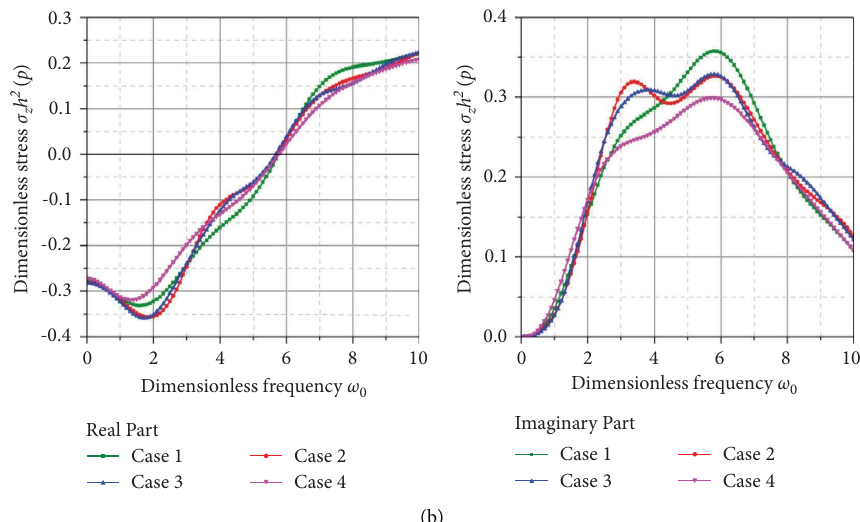
Figure 15: Te real and imaginary parts of (a) the vertical displacement and (b) the vertical stress at a fxed surface point ( r , θ , z ) � (0.5 h , 0, 0) for the diferent cases versus the dimensionless frequency.